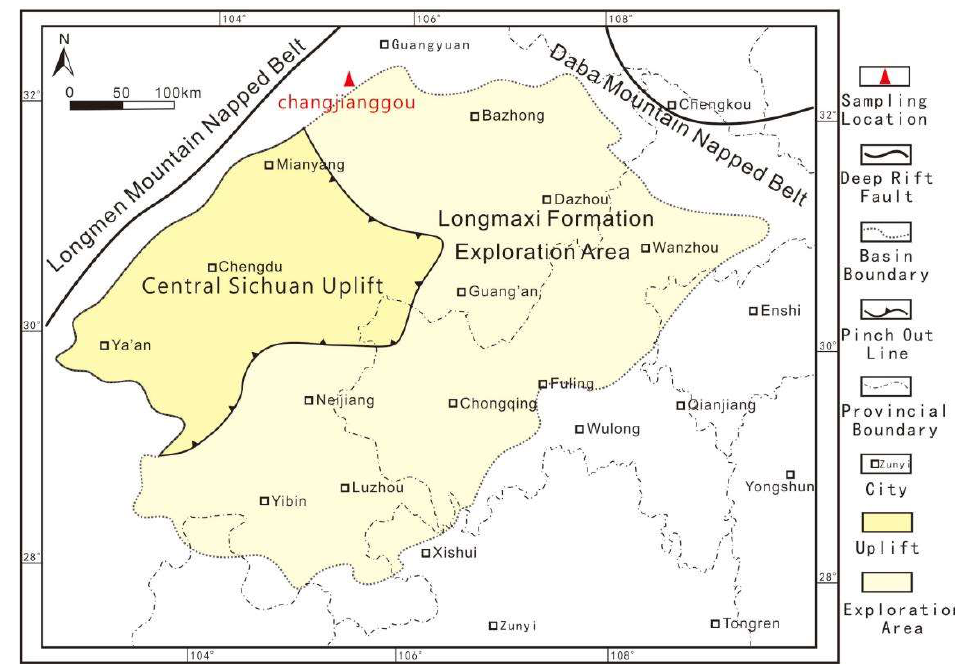
Figure 1. Sketch map of Sichuan Basin and the sampling location. Table 1. Sample data.